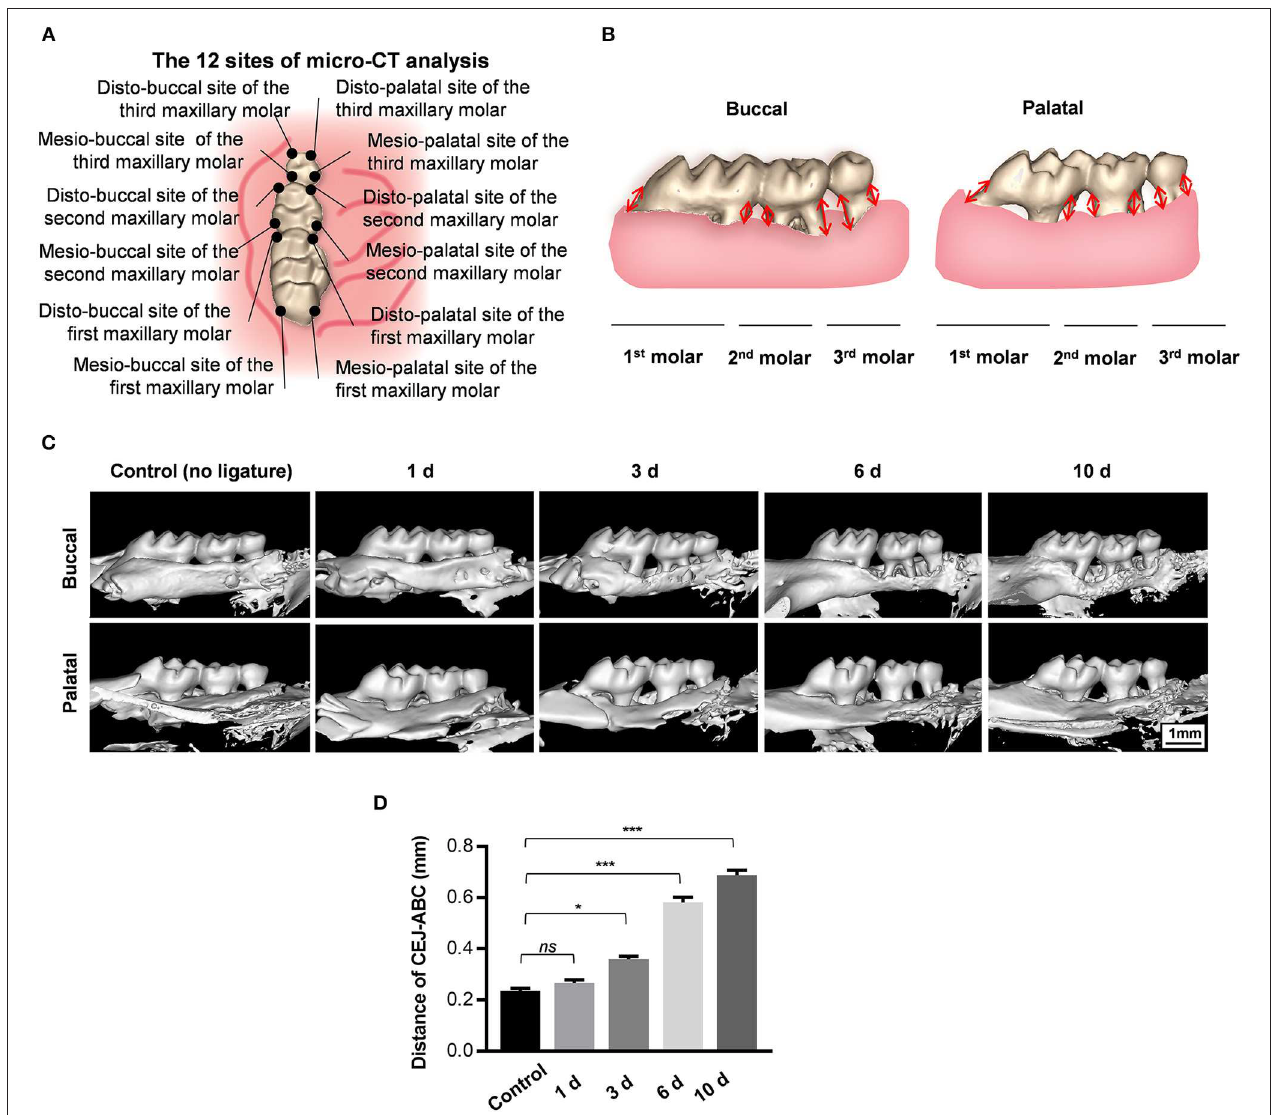
FIGURE 2 | Orthodontic ligature wire insertion induces progressive alveolar bone loss. (A) Anatomical direction of maxillary molars. (B) Schematics of strategy for bone loss measurement by assessing the distances from the cementoenamel junctions to the alveolar bone crest (CEJ-ABC) on buccal and palatal side. (C) Representative sagittal 3D images viewed from the buccal side and palatal side of the maxillary molars 0, 1, 3, 6, and 10 d after ligature-insertion. (D) Statistical analysis of the linear distance of CEJ-ABC 0, 1, 3, 6, and 10 d after experimental periodontitis operation. Data are shown as mean ± SD. (* P < 0.05, *** P < 0.001, ns, not significant, n = 3, One-way ANOVA, Tukey’s multiple comparisons